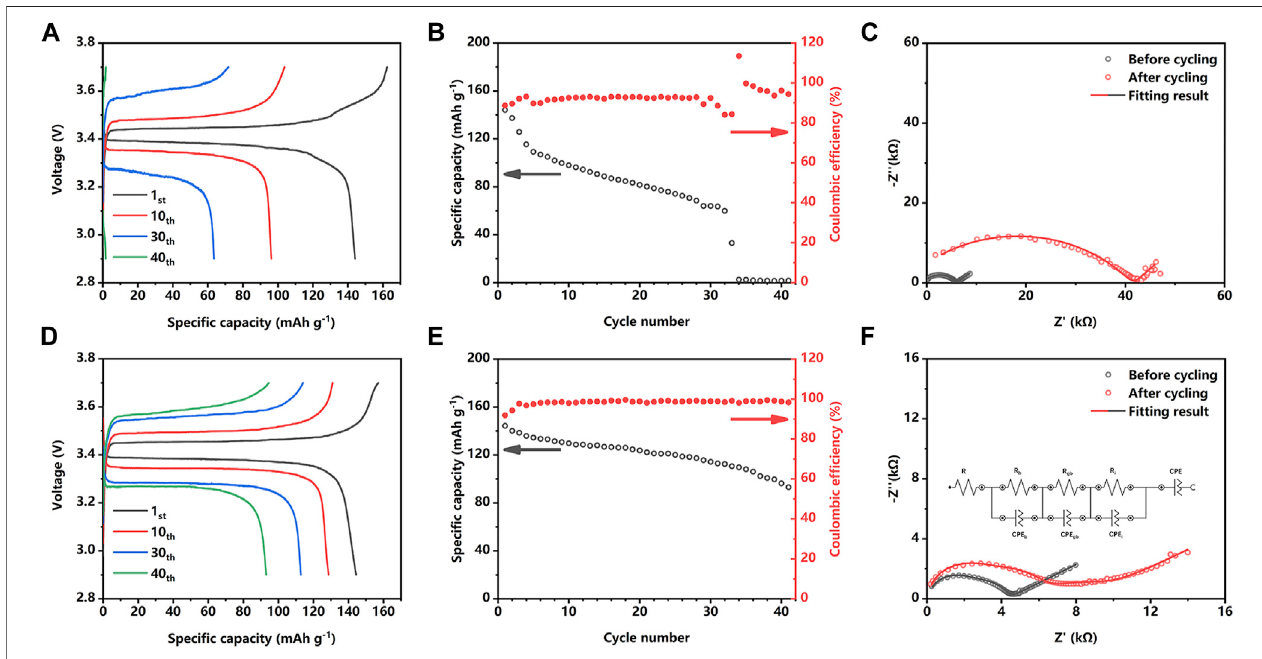
FIGURE3| Voltagepro fi les (A) andcyclingperformance (B) ofaLi/Li 2 OHCl/LFPcellwithoutLEoptimizationat0.2C.NyquistplotsofaLi/Li 2 OHCl/LFPcellwith and without (C) LE optimization at 0.2C before and after cycling. Voltage pro fi les (D) and cycling performance (E) of an LE optimization Li/Li 2 OHCl/LFP cell at 0.2C.